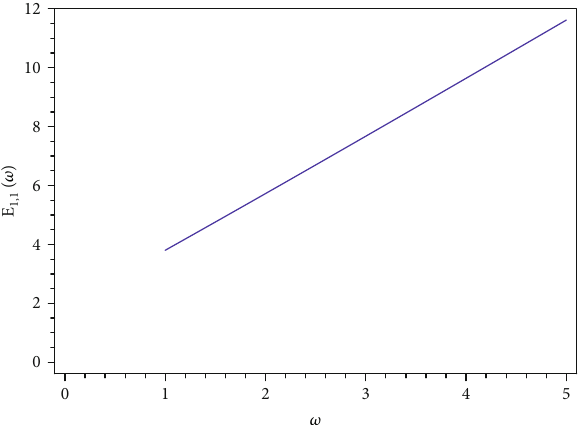
Figure 8: n = l = k = q = a = b = η